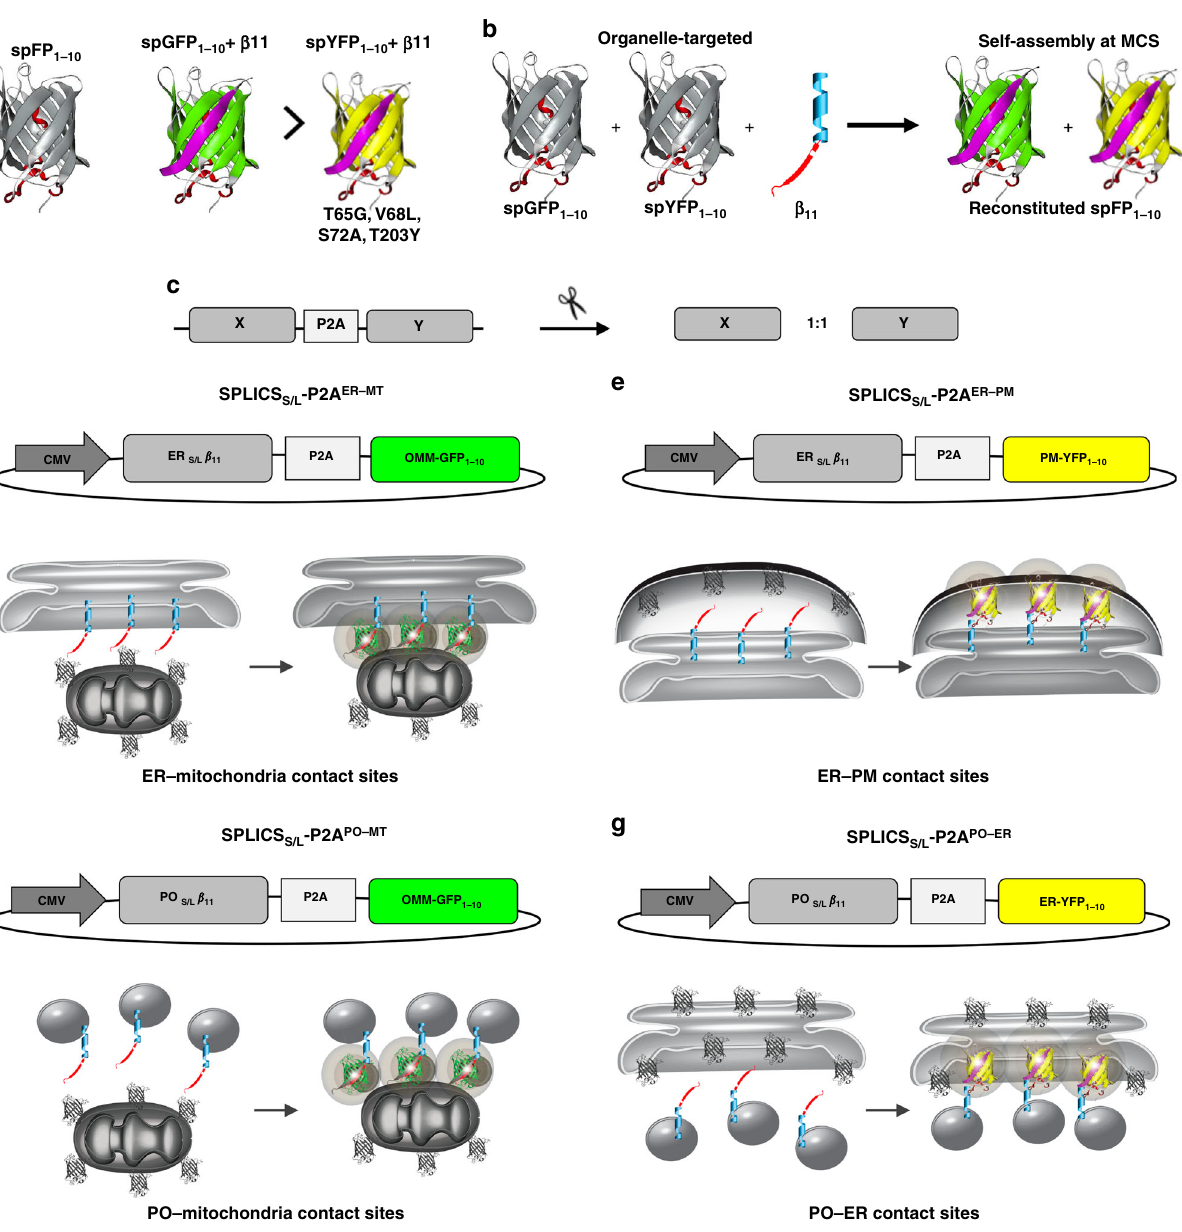
Fig. 1 Design of the SPLICS S/L -P2A probes. a Cartoon representation of GFP/YFP SPLICS S/L -P2A probes. The cartoon also indicates the occurrence of reconstitution of the two spectral variants through association with the invariant strand β 11 . b Schematic representation of the targeted GFP/YFP SPLICS S/L - P2A chimeras. GFP/YFP protein was split in two non- fl uorescent portions, G(Y)FP 1 – 10 and β 11 fragment that are targeted to outer face of organelles of interest. The complementation of targeted split-GFP at membrane contact sites was also shown in the cartoon. c Creation of a single vector for the equimolar expression of the targeted fragments through the insertion of the P2A peptide. d – g Schematic representations of the SPLICS S/L -P2A vectors. The β 11 S/L coding sequence is cloned upstream the viral P2A peptide sequence, while the second cassette is occupied by the G(Y)FP 1 – 10 . d SPLICS S/L -P2A expression plasmids (ER S/L - β 11 and OMM-GFP 1 – 10 ). e SPLICS S/L -P2A ER – PM expression plasmids (ER S/L - β 11 and PM-YFP 1 – 10 ). f SPLICS S/L -P2A PO –